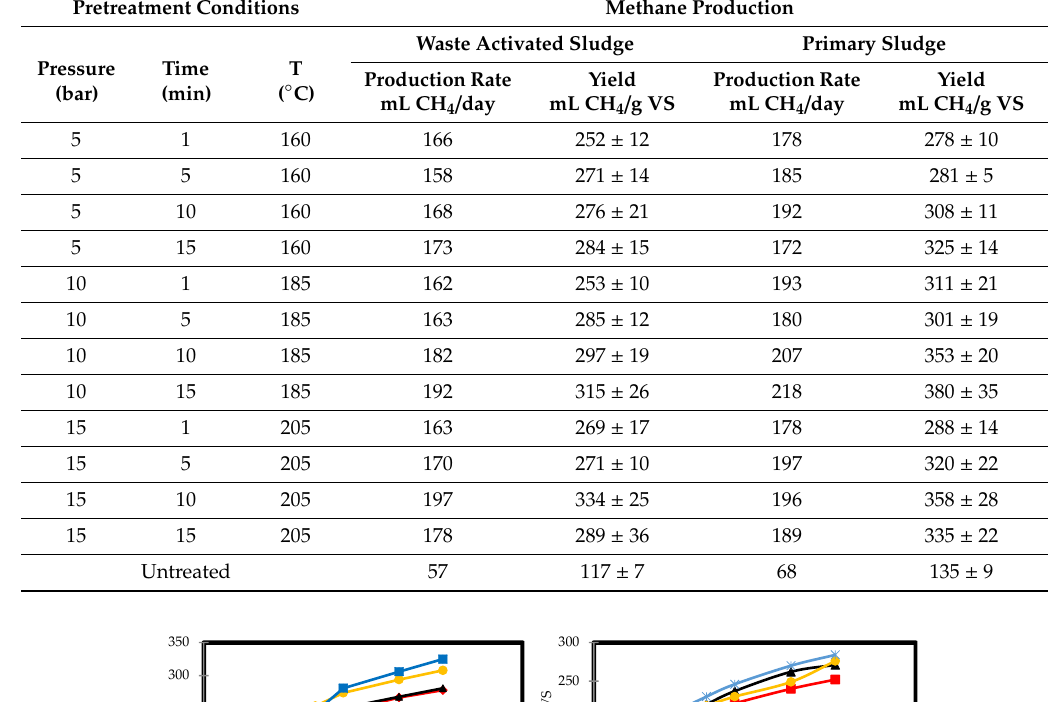
Table 2. E ff ect of steam explosion pretreatment on methane production.